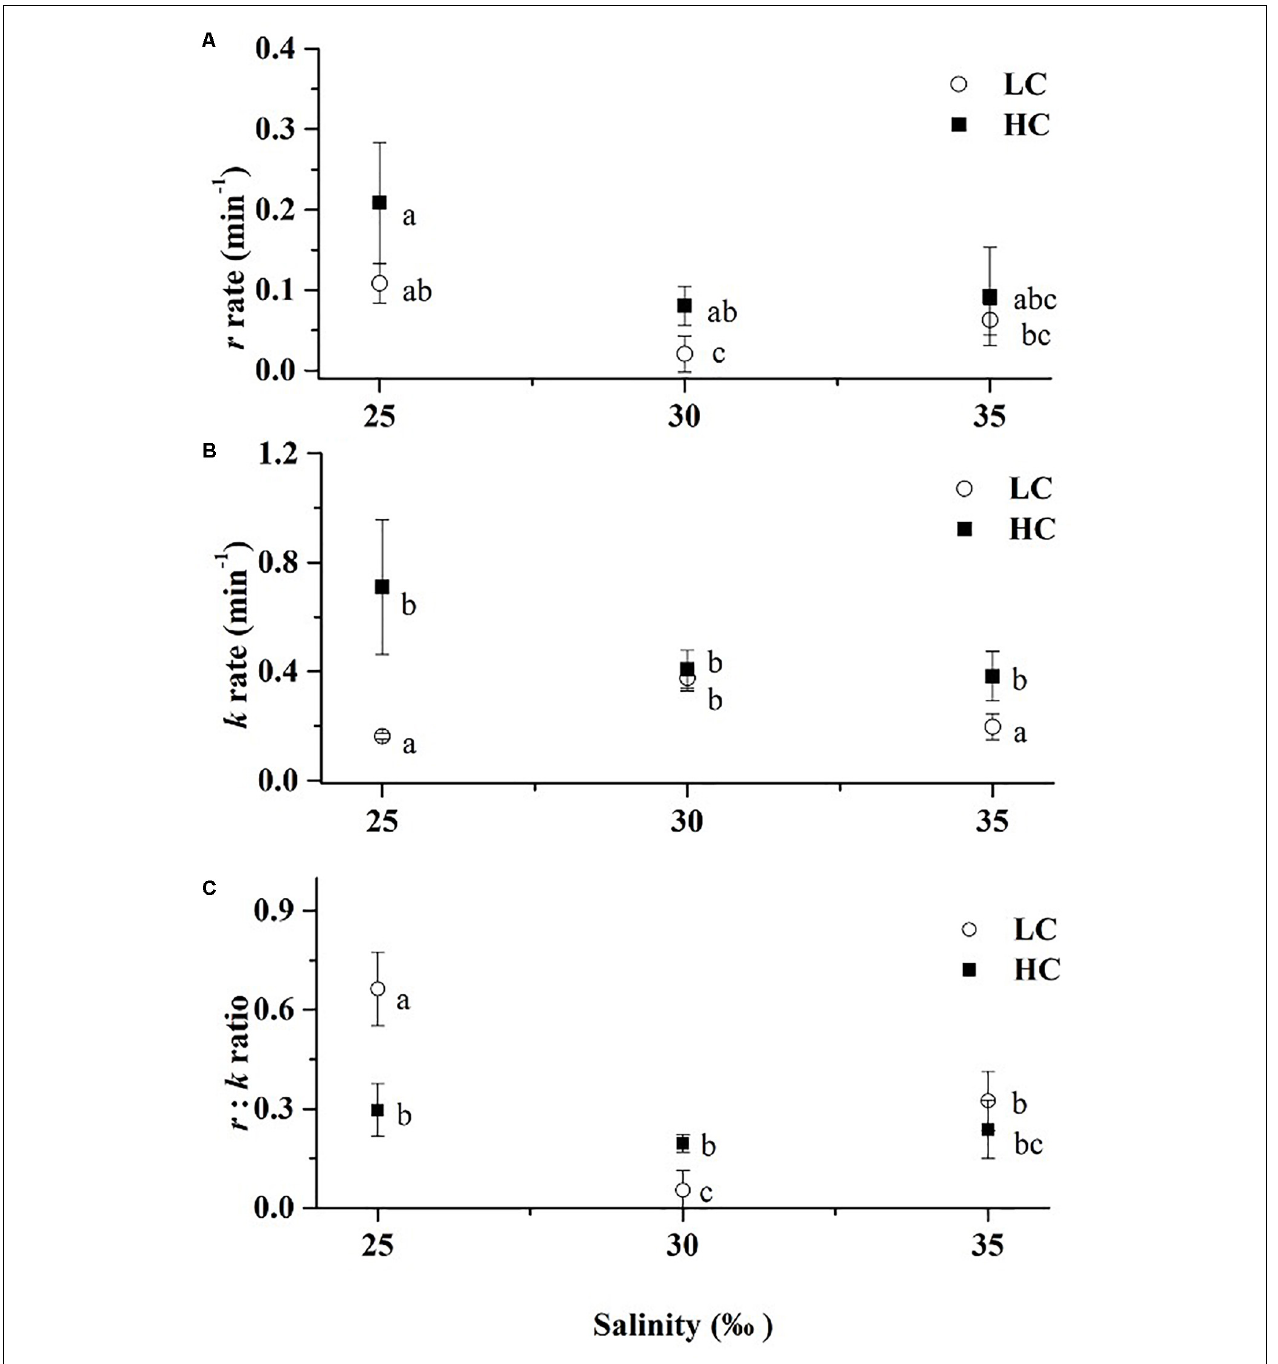
FIGURE 6 | Rate of Repair r (A) , damage k (B) and the ratio of repair:damage (C) after exposure to solar radiation for 48 min (800 µ mol photons m − 2 s − 1 ) under different treatments (LC, open circles; HC, solid squares). Values are means ± SD of triplicate cultures. Symbols with different lowercase letters indicate significant differences ( p < 0.05) among different